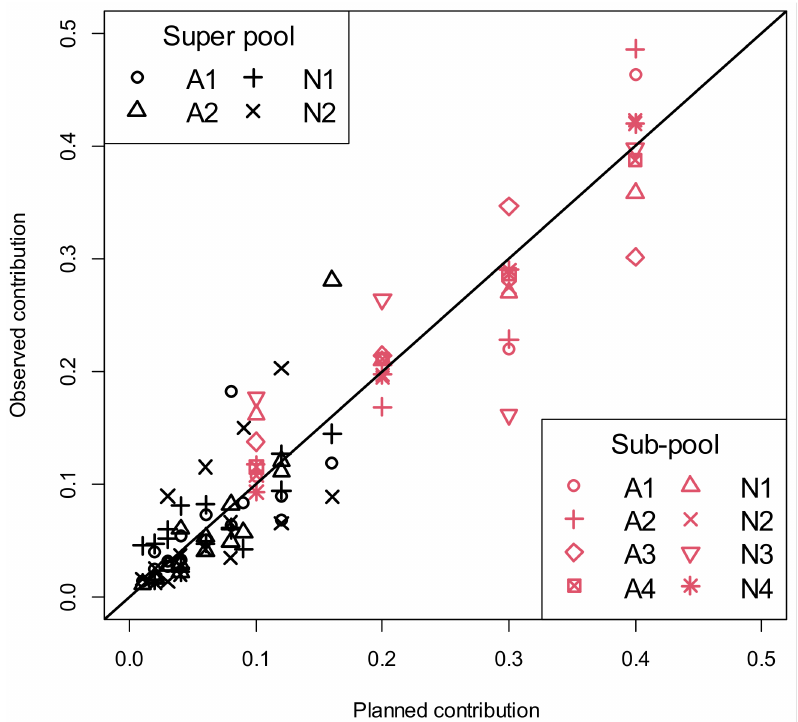
Figure 2. Pool construction errors are deviations of observed animal contributions from planned contributions for super and sub-pools. The solid black line depicts where observed and planned animal contributions are equal. Observed animal contributions were estimated by quadratic pro- gramming [9] minimizing error sums of squares subject to animal contributions summing to 1 and animal contributions ≥ 0. In legends, sub-pools or super pools starting with A or N are from cattle with liver abscess or normal livers,